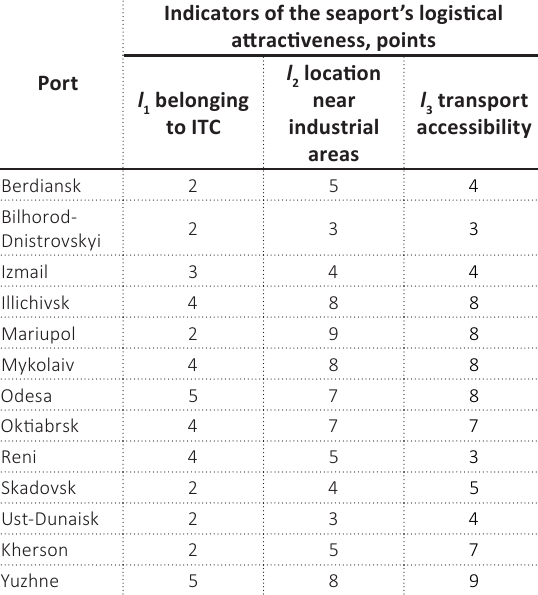
Table 5. Indicators of logistical attractiveness of Ukrainian